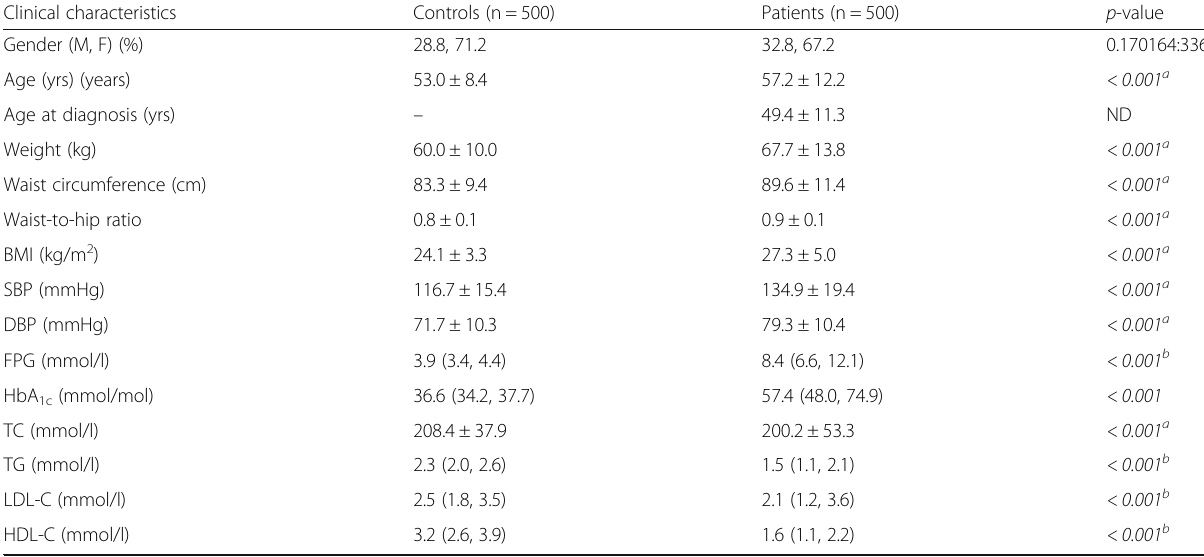
Table 1 Demographic, anthropometric, and clinical characteristics of the control and patient study groups Clinical